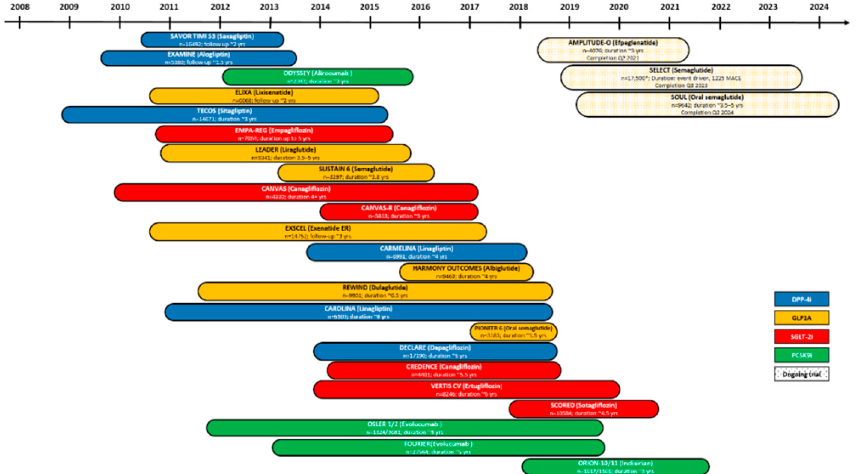
Figure 1. Clinical trials with cardiovascular end ‐ points for T2DM patients in trials for incretin ‐ based and SGLT2i therapies and with LDL ‐ C percentage change from baseline end ‐ points for trials testing and SGLT2i therapies and with LDL-C percentage change from baseline end-points for trials testing PCSK9i. Based on https://clinicaltrials.gov/ct2/home (accessed 10 December 2020). PCSK9i. Based on https://clinicaltrials.gov/ct2/home (accessed 10 December